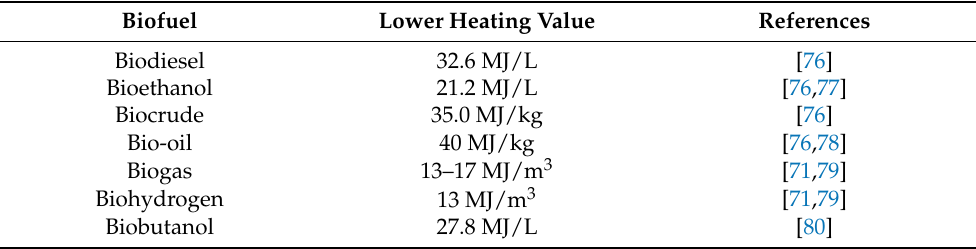
Table 6. Main biofuels, the associated energy and corresponding processing routes reported in the